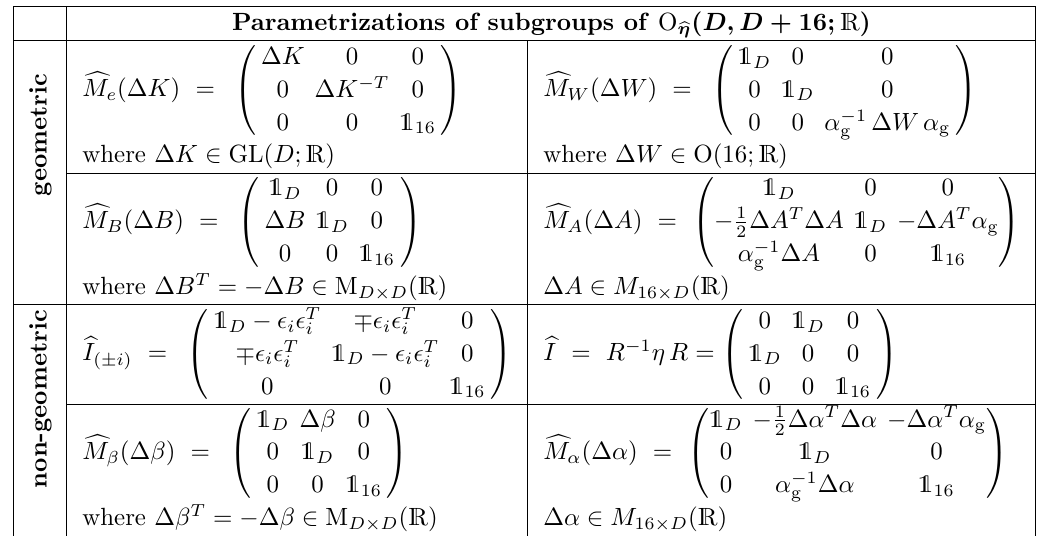
Table 1 . This table lists various subgroup elements of the duality group O